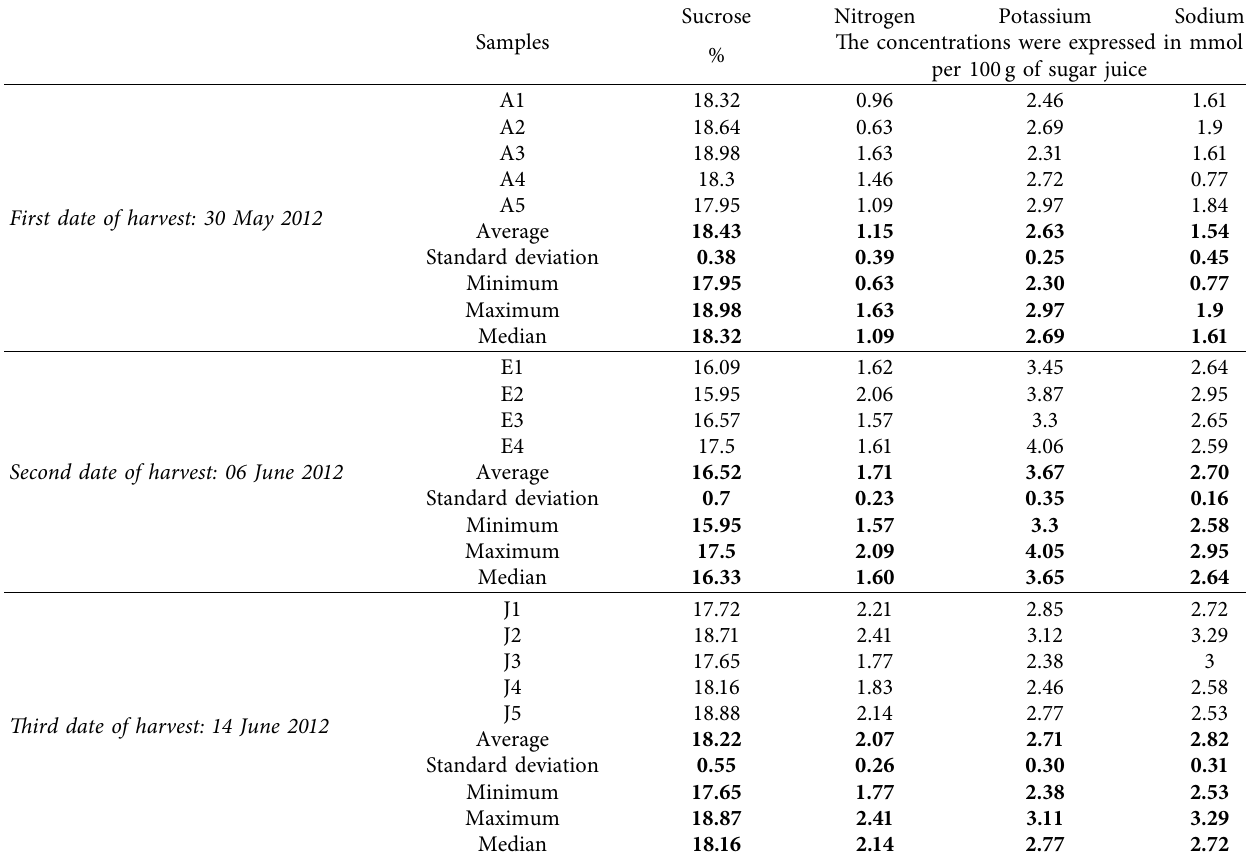
Table 1: Analytical and statistical data related to the parameters studied in the three harvest